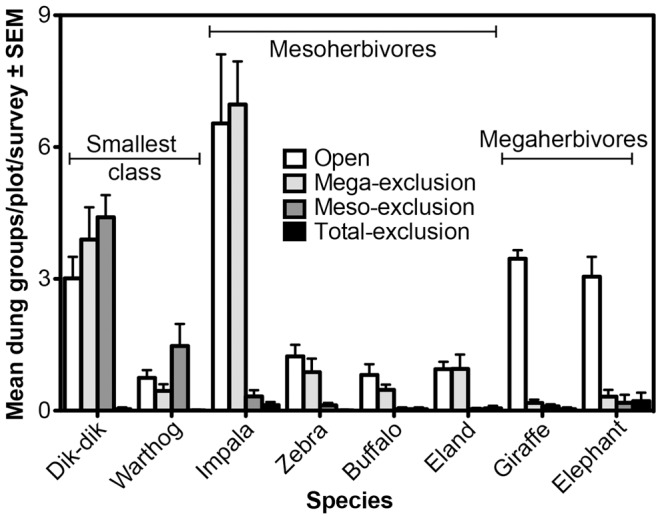
Patterns of dung deposition by the eight most common LMH species, arranged in order of increasing body mass.Data are the mean number of dung groups per plot across eight surveys from April 2009 to November 2011.